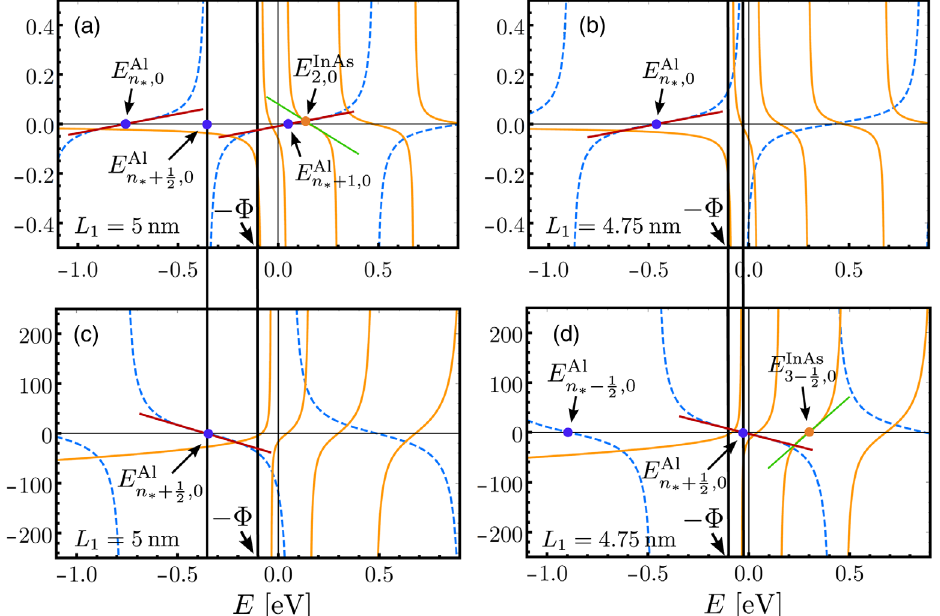
FIG. 11. Plot of the lhs (dashed blue lines) and rhs (solid gold lines) of the direct and inverted transcendental Eqs. (C1) and (C2) for Φ ¼ 0 . 1 eV and L 0 16 nm. In (a) and (c) L 5 nm, and in (b) and (d) L 4 . 75 nm. The eigenenergies are obtained when the lhs 1 ¼ 1 ¼ 2 ¼ and rhs lines cross. Depending on the energy regime, it is convenient to use the direct or inverted transcendental equation in order to obtain the eigenspectrum. The approximate analytical expressions for the eigenenergies are obtained via a Taylor expansion of the lhs or/ and the rhs about zeros of the respective tangent or cotangent. These zeros are related to the pure Al and InAs levels and the values E Al and E InAs , as well as E Al and E InAs . Panel (a) is employed for inferring weakly modified Al-like bands and InAs-like bands within n;k n þ 1 = 2 ;k n þ 1 = 2 ;k scenario I. Panel (b) is employed for inferring weakly modified Al-like bands within scenario II. Panel (c) is employed for inferring the Al-InAs gluing segments within scenario I. Panel (d) is employed for inferring modified InAs-like bands within scenario